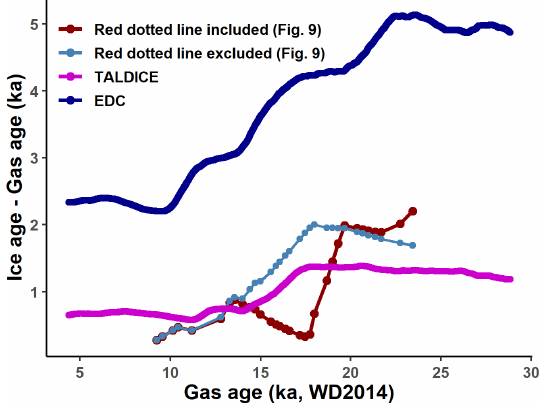
Figure C2. EDC, TALDICE, and Larsen BIA (cid:49) age. (cid:49) age for the Larsen BIA is defined as (ice age) − (gas age) at 1.95m depth. The EDC WD2014 chronology is from Buizert et al. (2021).